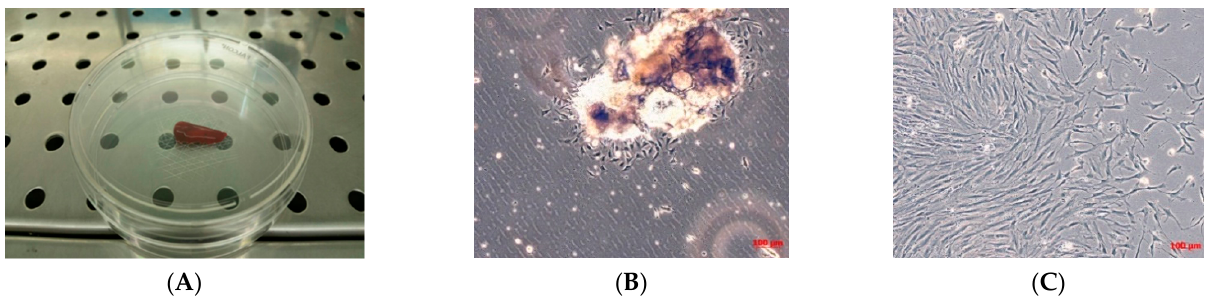
Figure 1. Biopsy specimen and primary cell culture of TOS. ( A ) Biopsy specimen of TOS by needle aspiration. Observation in phase contrast of primary cell culture of TOS after 24 h from enzymatical and mechanical treatment of the biopsy ( B ) and after three days ( C ). Original magnification 10×.